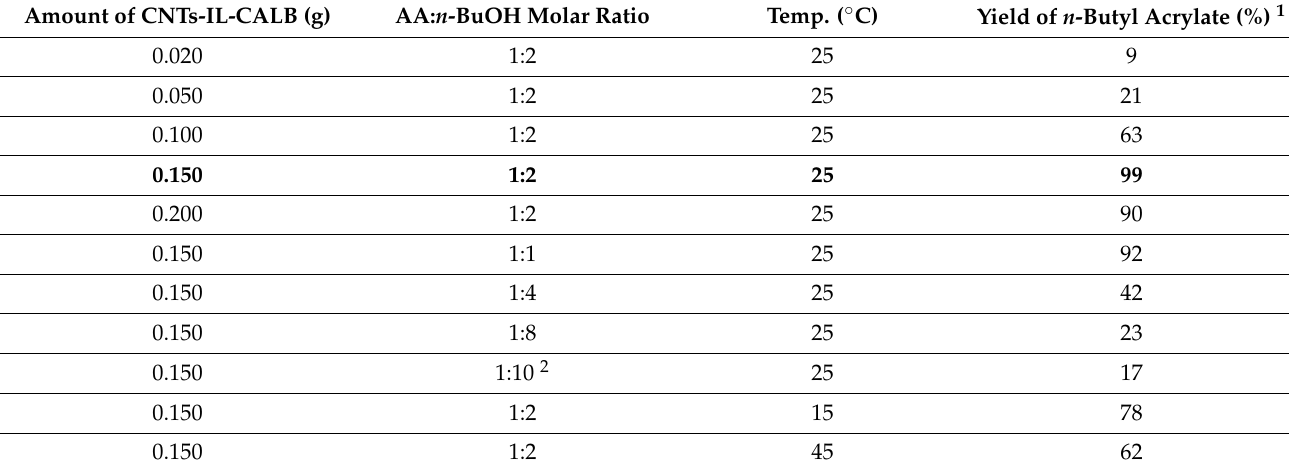
Table 3. The influence of the selected parameters on the yield of n -butyl